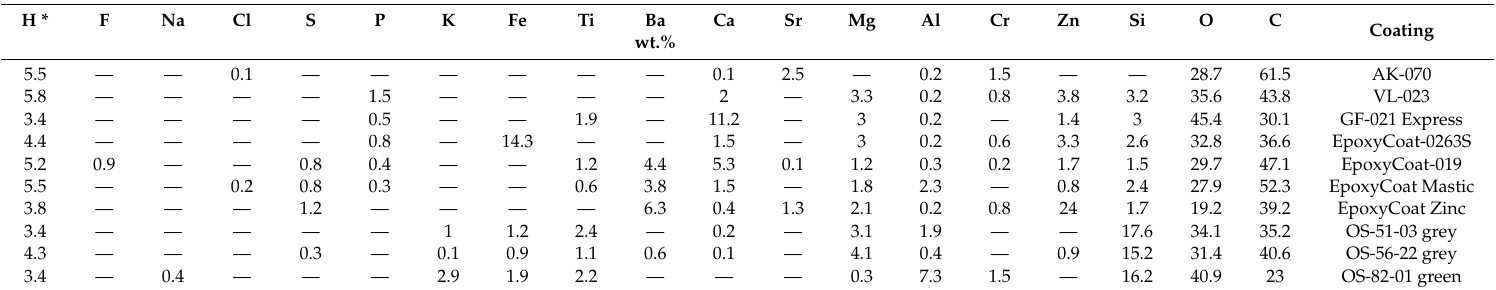
Table 3. Coatings element